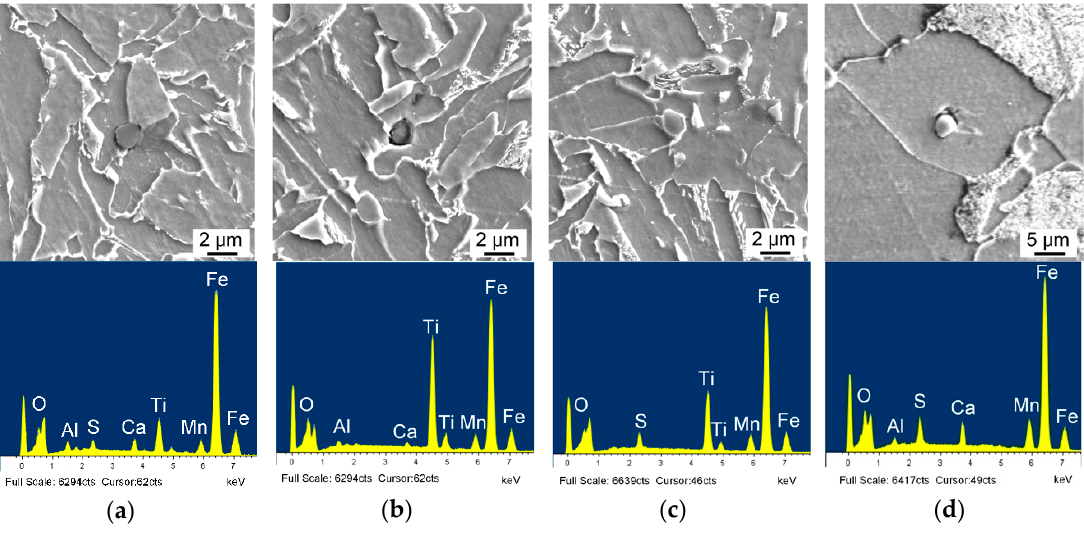
Figure 3. Typical inclusions in ( a – c ) TC# steel and ( d ) AC# steel.